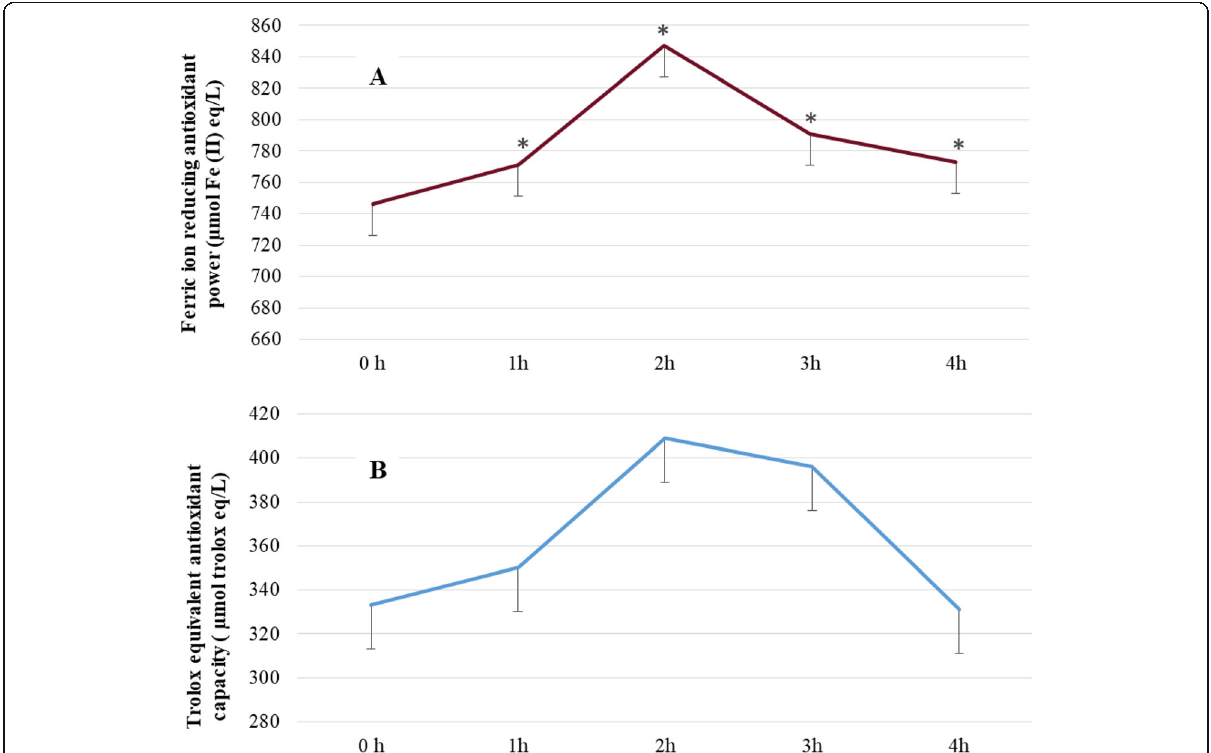
Fig. 1 Short term efficacy of porridge consumption on plasma antioxidant capacity. a Ferric ion reducing antioxidant power. b Trolox equivalent antioxidant capacity; * Significantly different from base line at p <